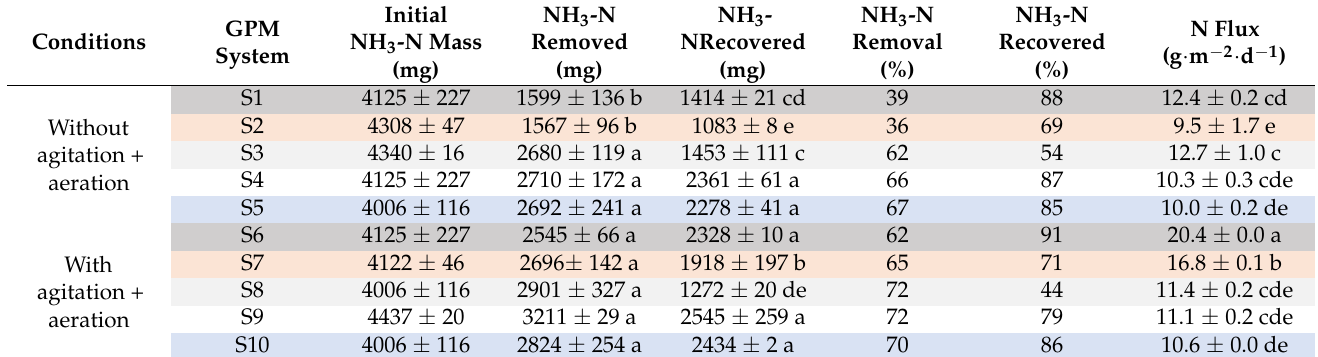
Table 1. Mass balance of NH 3 -N recovered using the different configurations of the GPM system. Mass of NH 3 -N in the slurry at the beginning of the experiment (Initial NH 3 -N mass), mass of NH 3 -N emitted (NH 3 -N removed), mass of NH 3 -N recovered in the acidic solution (NH 3 -N recovered), NH 3 removal and NH 3 recovery efficiencies (NH 3 -N removal and NH 3 -N recovered, respectively), and N flux rate (N